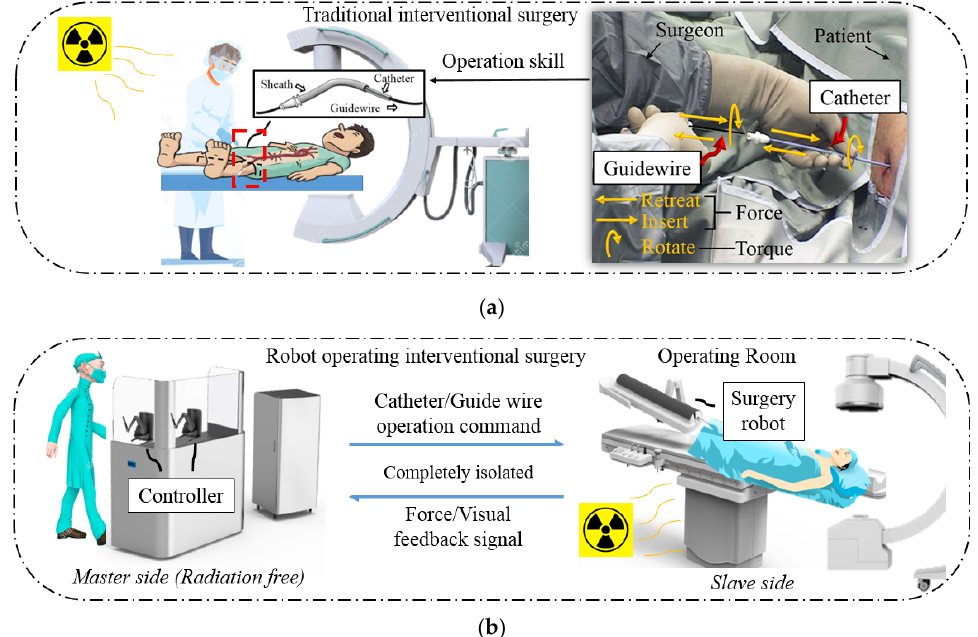
Figure 1. Routine operation procedure of interventional surgery and advantages of robot operation compared to the traditional method. ( a ) Traditional interventional surgery needs to be conducted in the operating room. The surgeon manipulates the catheter with one hand and guidewire with the other. The delivery (insert), withdrawal (retreat), and twisting (rotate) of the catheter and the guidewire are involved when passing through different blood vessels during the operation. ( b ) Robot- assisted surgery can be conducted outside the operating room. The surgeon can be protected from radiation, operate the catheter and guidewire remotely using the robot’s controller.